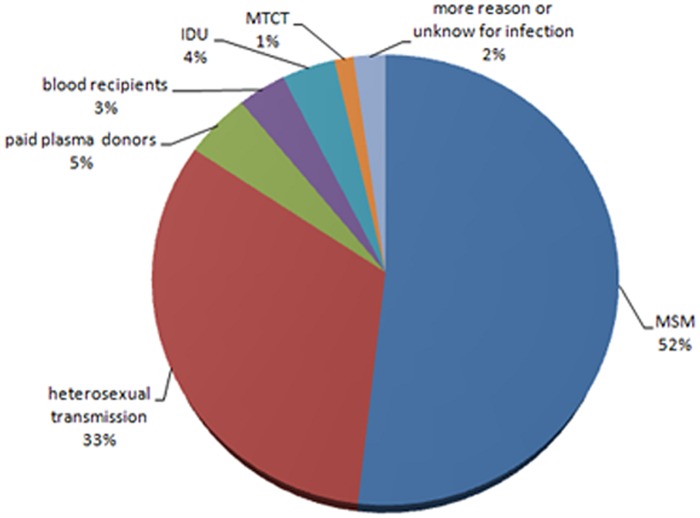
Distribution of transmission routes in Hebei.